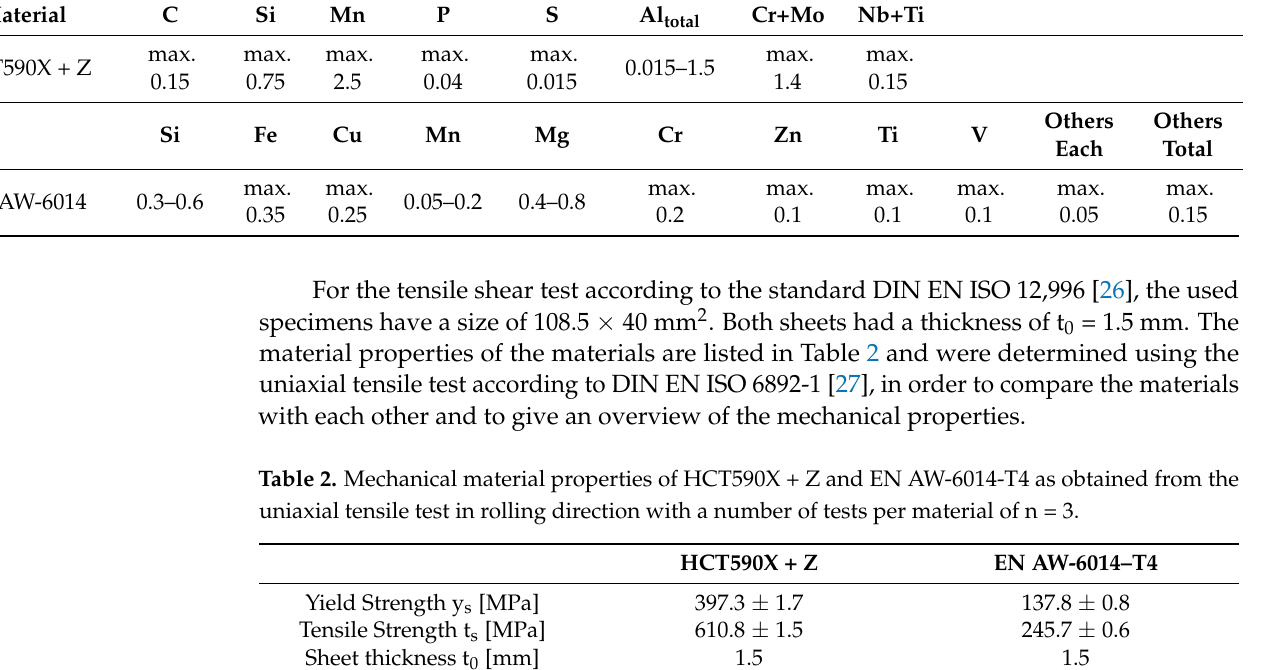
Table 1. Chemical composition of HCT590X + Z and EN AW-6014-T4 in weight-%. Material